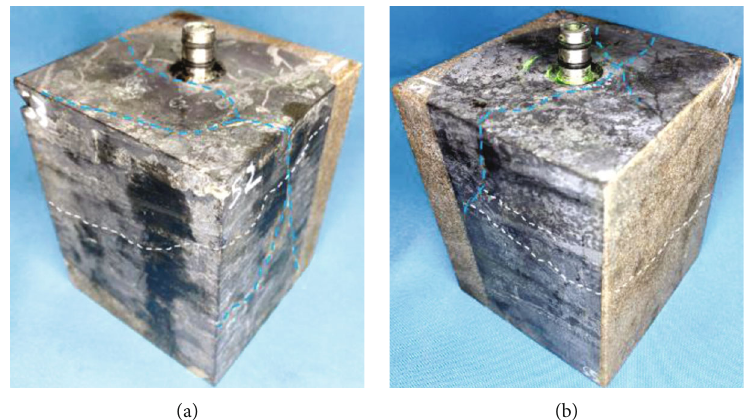
Figure 8: Diagram of sample after fracturing. (a) Sample 6#. (b) Sample